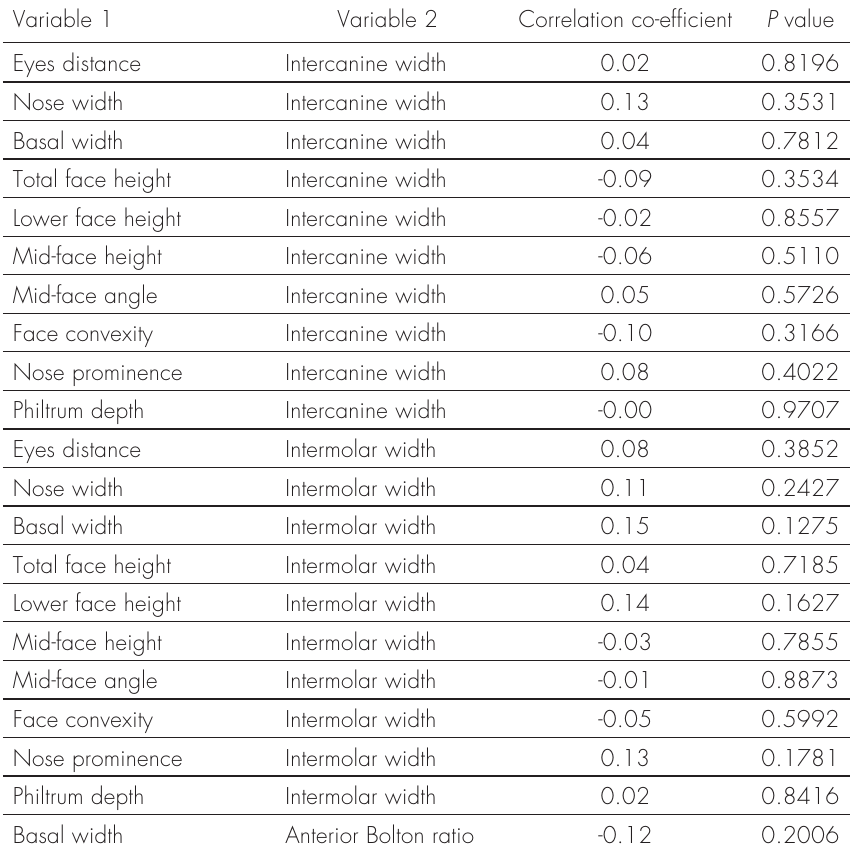
Table VII. Correlations and P